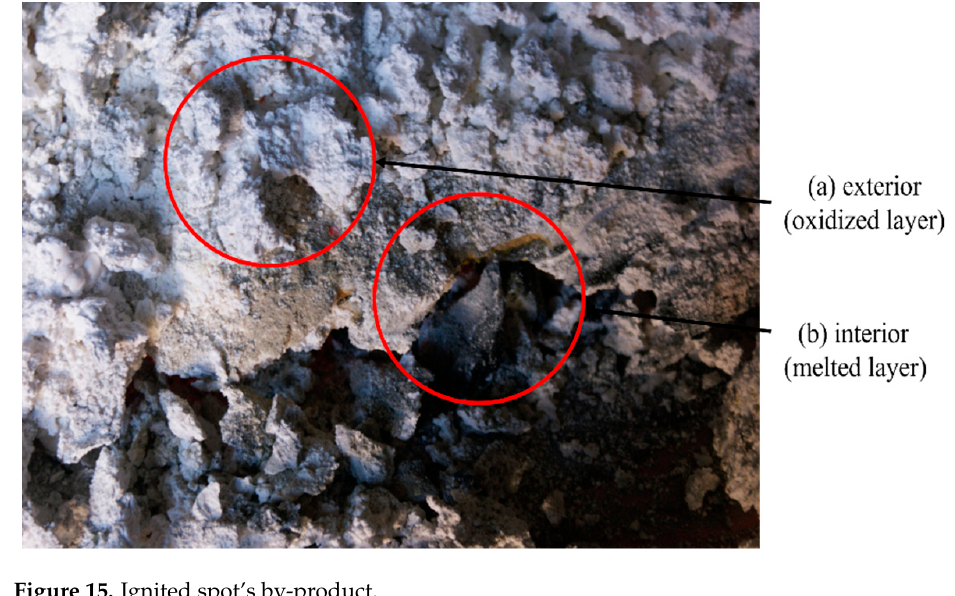
Figure 15. Ignited spot’s by-product.